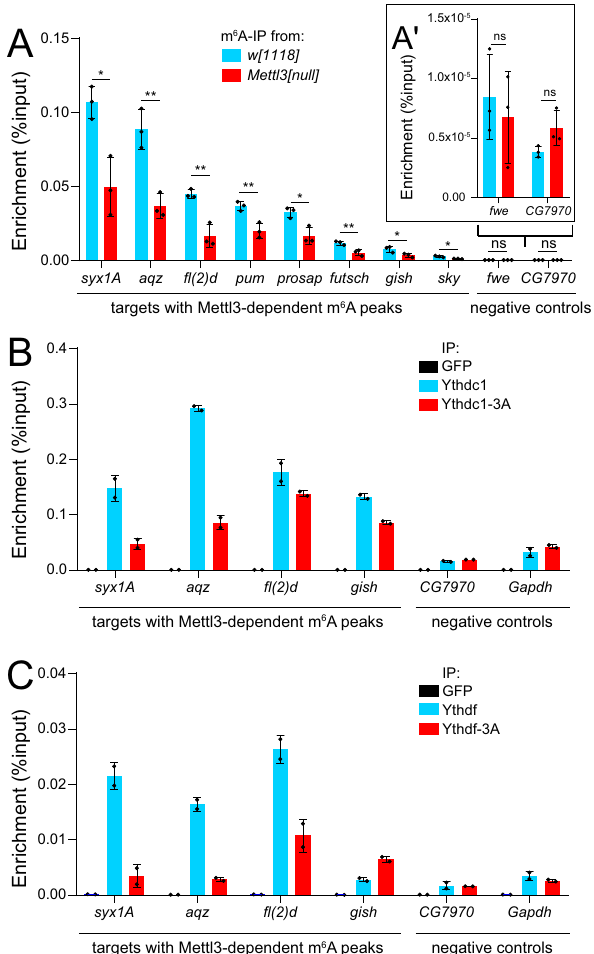
Fig. 5 Validation of Drosophila m 6 A targets and their association with readers. A – A ′ m 6 A-RIP-qPCR validation of m 6 A transcripts in w[1118] control and Mettl3[null] knockout whole female fl ies. Error bars, mean ± SD; n = 3 biological replicates. Two-tailed t -test, * p < 0.05, ** p < 0.01. syx1A p = 0.012, aqz p = 0.005, fl (2)d p = 0.004, pum p = 0.009, prosap p = 0.016, futsch p = 0.009, gish p = 0.044, sky p = 0.010. n.s. non-signi fi cant, fwe p = 0.604, CG7970 p = 0.085. B and C RIP-qPCR of m 6 A targets in S2- S cells and transfected Ythdc1 ( B ) or Ythdf ( C ) constructs shows speci fi c pulldown of several targets relative to GFP-RIP control, and the association of several of these is compromised by mutation of the YTH domain (3A versions). Shown is one representative result from three independent repeats. Source data are provided as a Source Data fi unaltered in Mettl3[null] samples (Fig. 5A ′ ). These data provide stringent validation of our m 6 A maps.